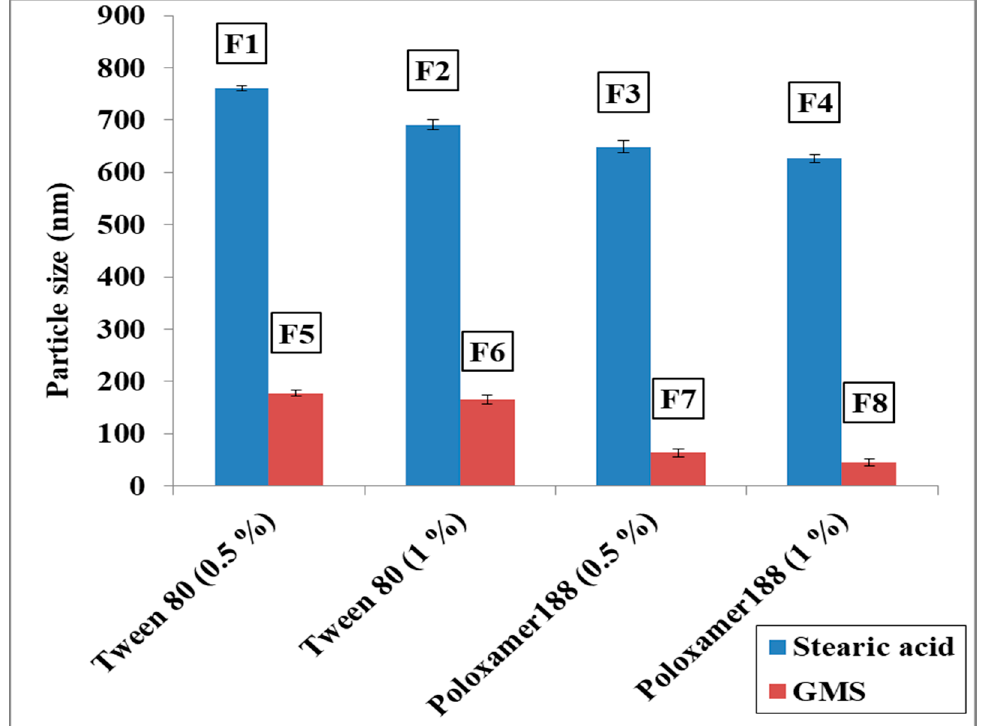
Figure 2. The effect of lipid type and surfactant concentration on the particle size of the prepared carbamazepine solid lipid nanoparticles formulations.